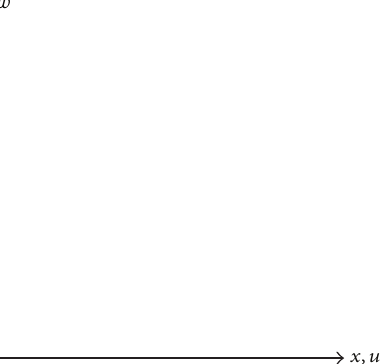
Figure 1: Coordinate